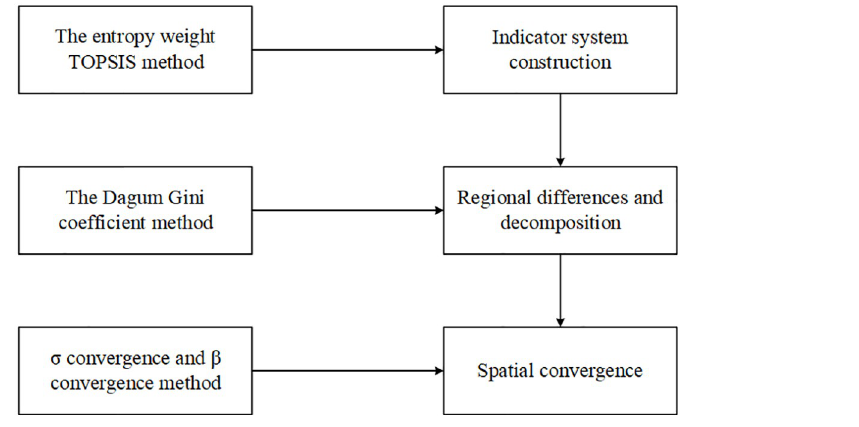
Fig 1. The relationship between research